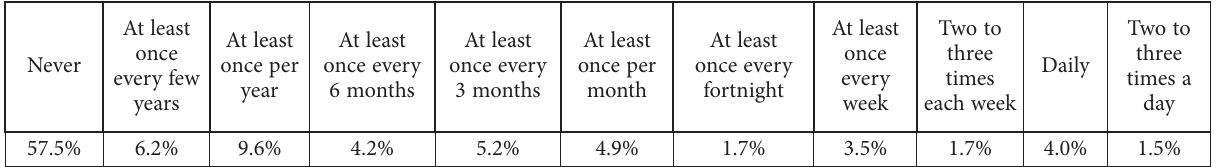
Table 2. Frequency of disturbance by trypophobic stimuli (Natural)